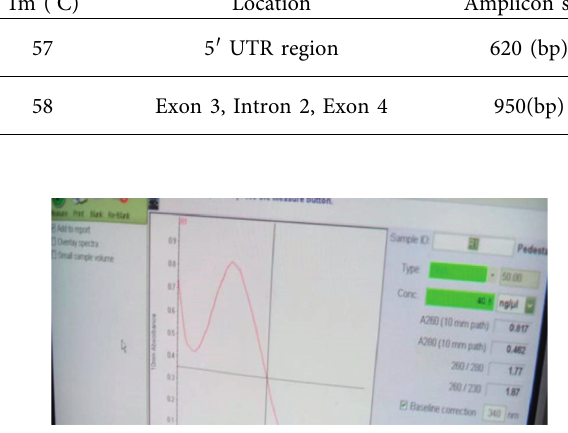
Figure 3: DNA quantification for UCP2 gene.